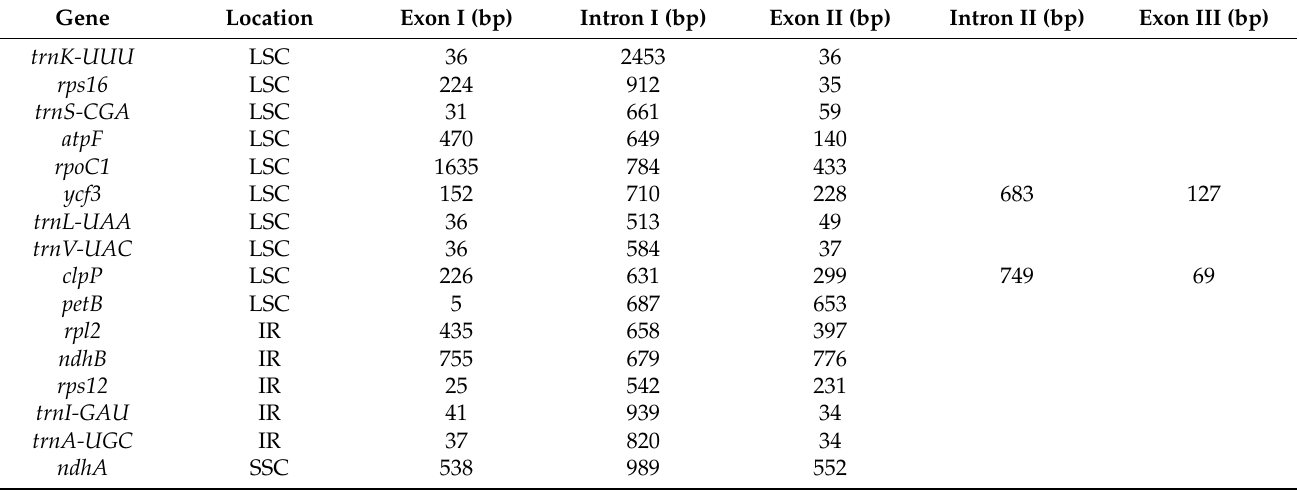
Table 3. Genes with introns in the H. forskaolii chloroplast genome and length of introns and exons.